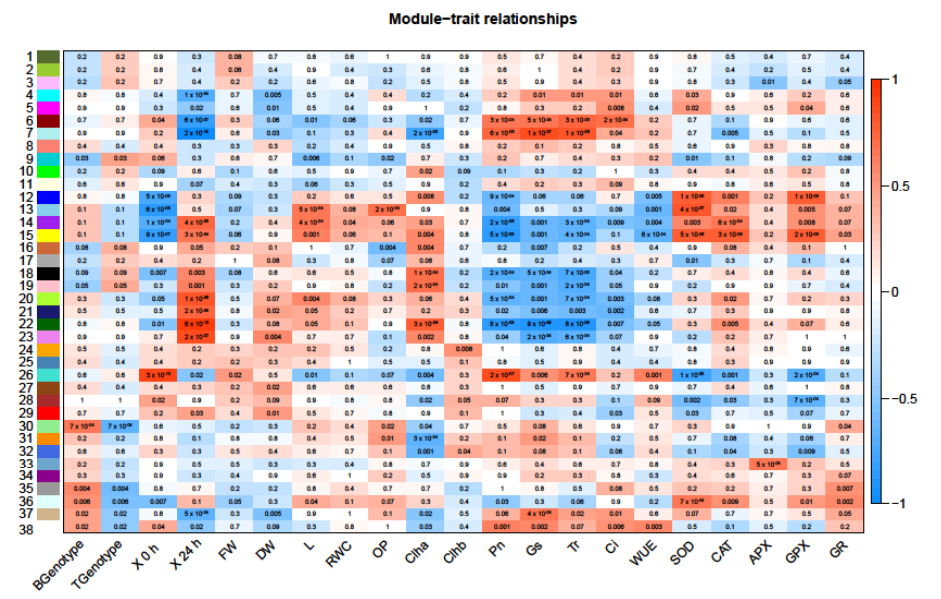
Figure 6. Correlation of WGCNA co-expression modules to each genotype. The analysis considered several parameters including genotype (Boulifa, B and Testour, T), stress duration (0 h, 24 h) and morpho-physiological traits (fresh weight (FW), dry weight (DW), shoot length (L), relative water content (RWC), osmotic potential (OP), chlorophyll a/b content (Chl and Chl b), net CO 2 assimilation rate (Pn), stomatal conductance (Gs), transpiration rate (E), internal concentration of CO 2 (Ci), water use efficiency (WUE), superoxide dismutase (SOD), catalase (CAT), ascorbate peroxidase (APX), guaiacol peroxidase (GPX), and glutathione reductase (GR)). Each numbered row corresponds to a module, each column to a trait (labelled along x -axis). Each cell contains the corresponding p -value and is color-coded by the strength of correlation according to the legend on the right (red and blue shading indicates level of correlation and ranges from +1 to −